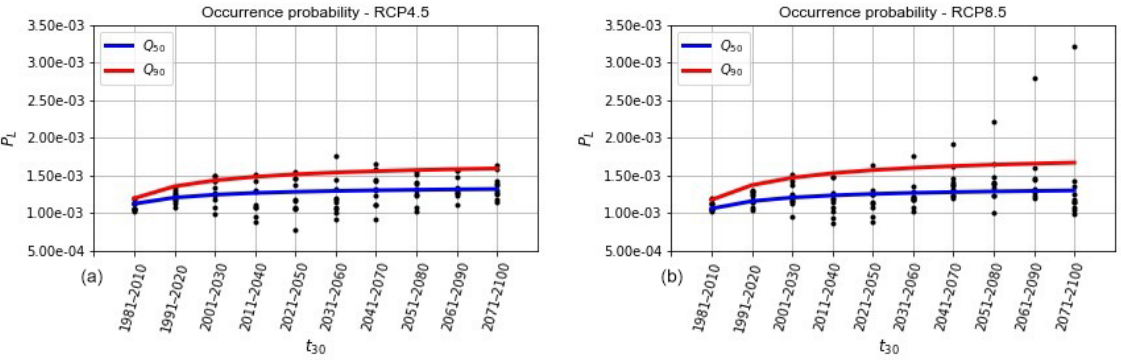
Figure 9. Fitting of modified geometrical models to landslide occurrence probability ensemble data for quantiles Q 50 and Q 90 : (a) RCP4.5 and (b) RCP8.5.